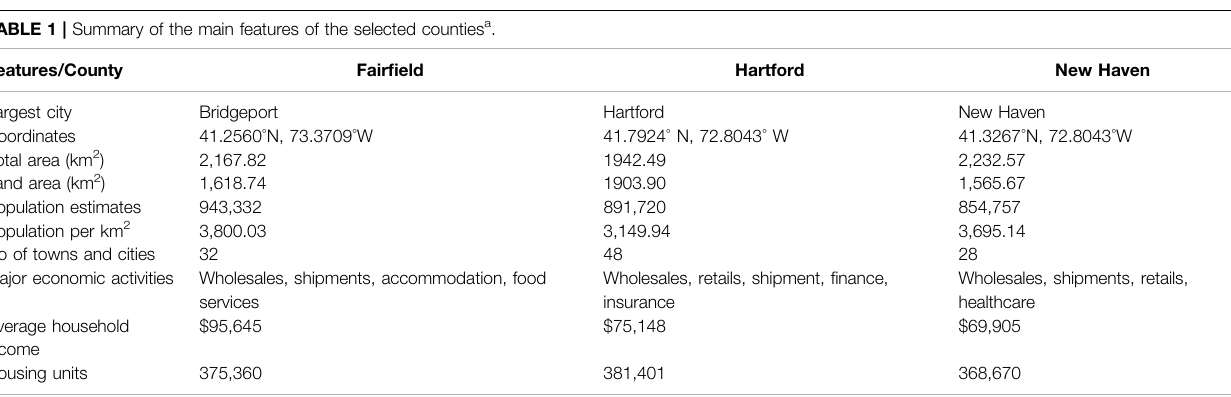
TABLE 1 | Summary of the main features of the selected counties a . Features/County